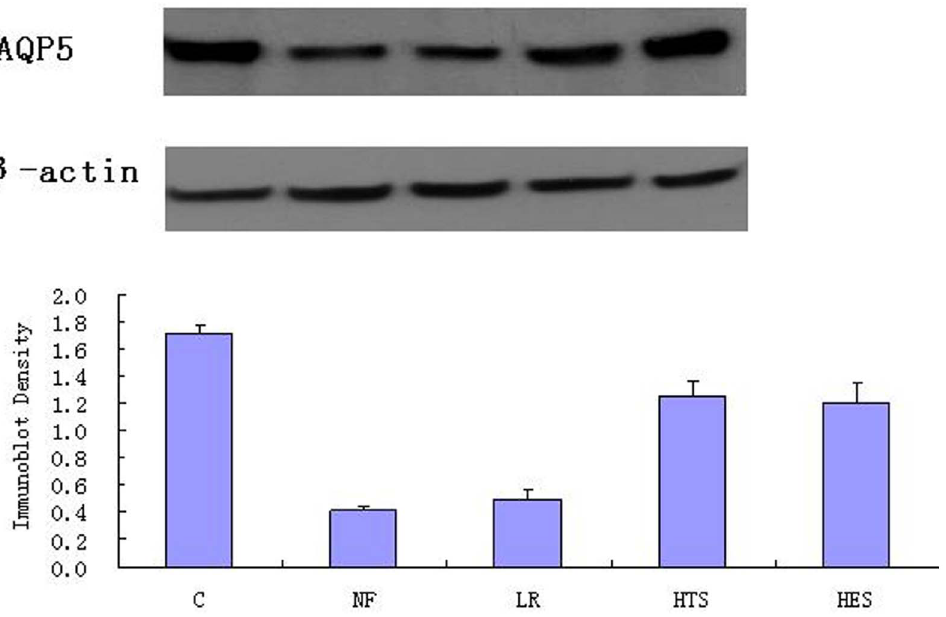
Figure 2. Western Blot Analysis for AQP5 in the lung tissues. Protein were extracted and subjected to Western blot analysis with use of polyclonal antibody against AQP5. Lanes are as follows: 1, Group C; 2, Group NF; 3, Group LR; 4, Group HTS; 5, Group HES. Data presented are means 6 standard deviation (SD) of three or four separate experiments. g P , 0.05 versus Group C; + P , 0.05 versus Group NF; * P , 0.05 versus Group LR.